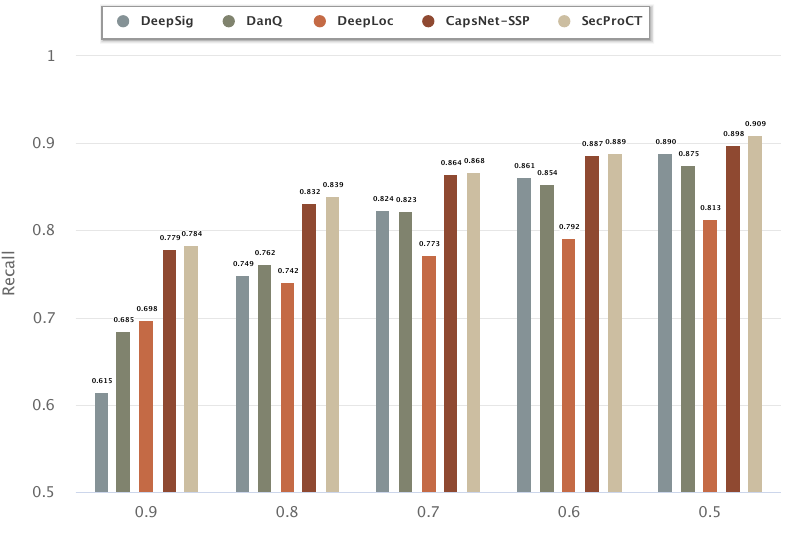
Figure 1. Prediction results of known blood-secretory